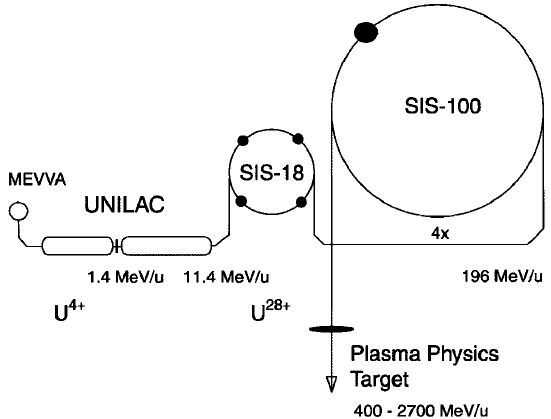
FIG. 1. A schematic diagram of the accelerator chain for beam-matter interaction